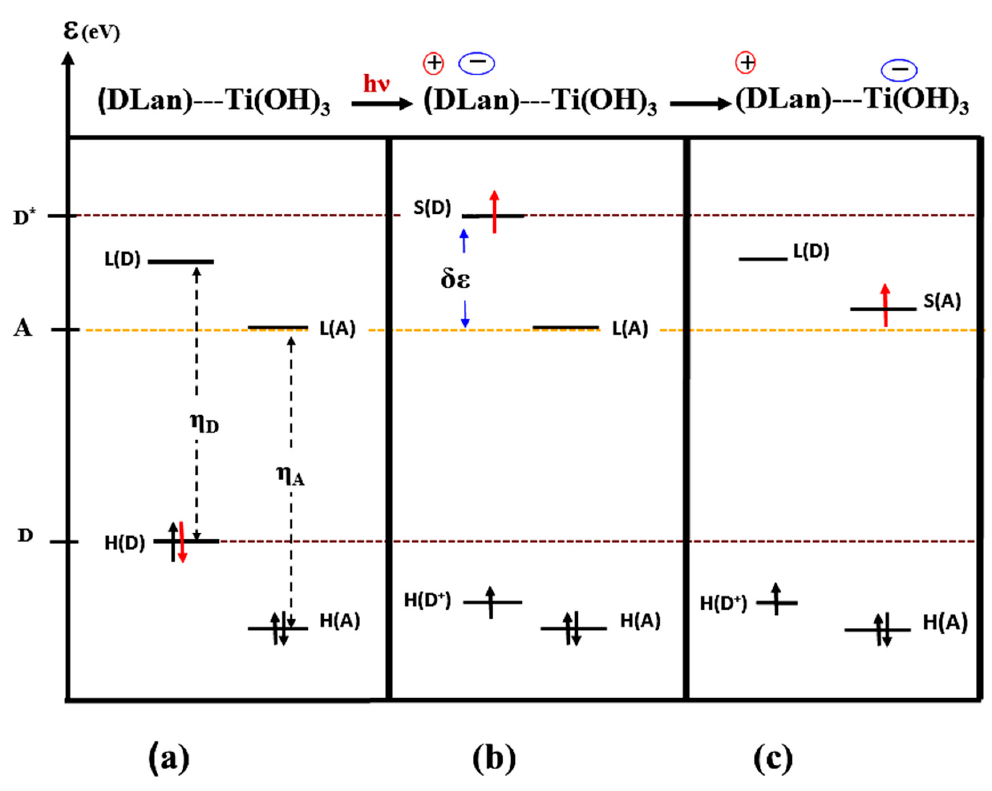
Figure 25. Molecular orbitals involved in the electron injection: ( a ) Ground state; ( b ) thexi state; ( c ) charge separate state. H(D) = HOMO of the Donor, L(D) = LUMO of the Donor S(D) = SOMO of the Donor, η D , η A = Hardness of Donor and Acceptor.